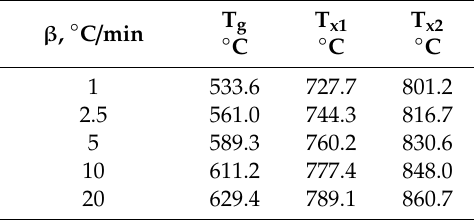
Table 1. The characteristic temperatures of the crystallization of 93GeO 2 –6Al 2 O 3 –1Bi 2 O 3